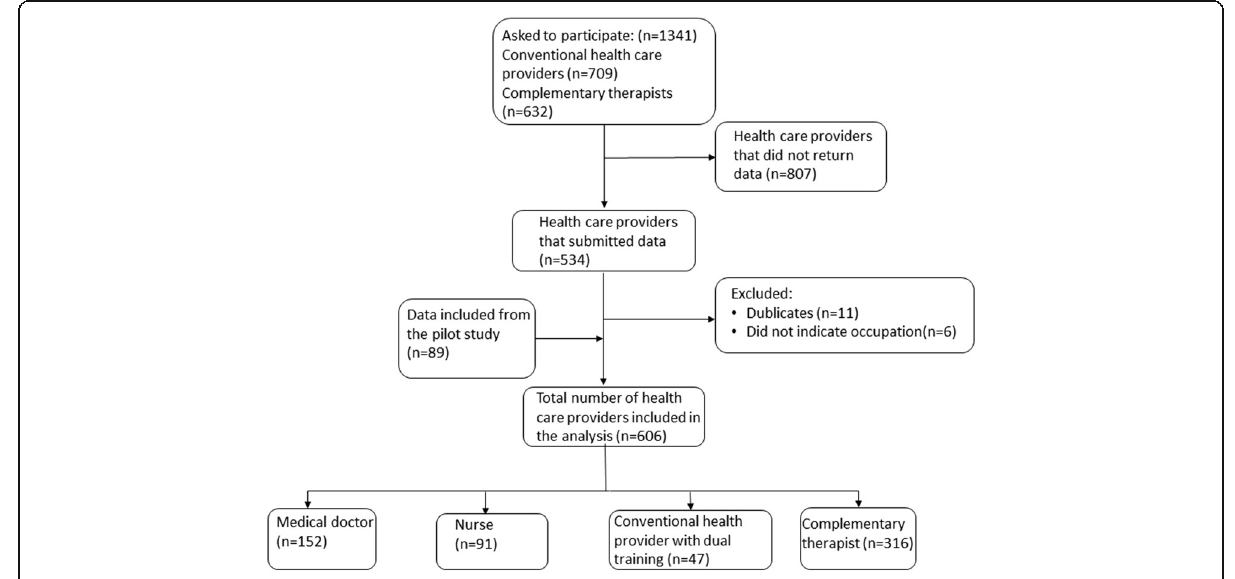
Fig. 3 Flow chart of the inclusion process in the Main